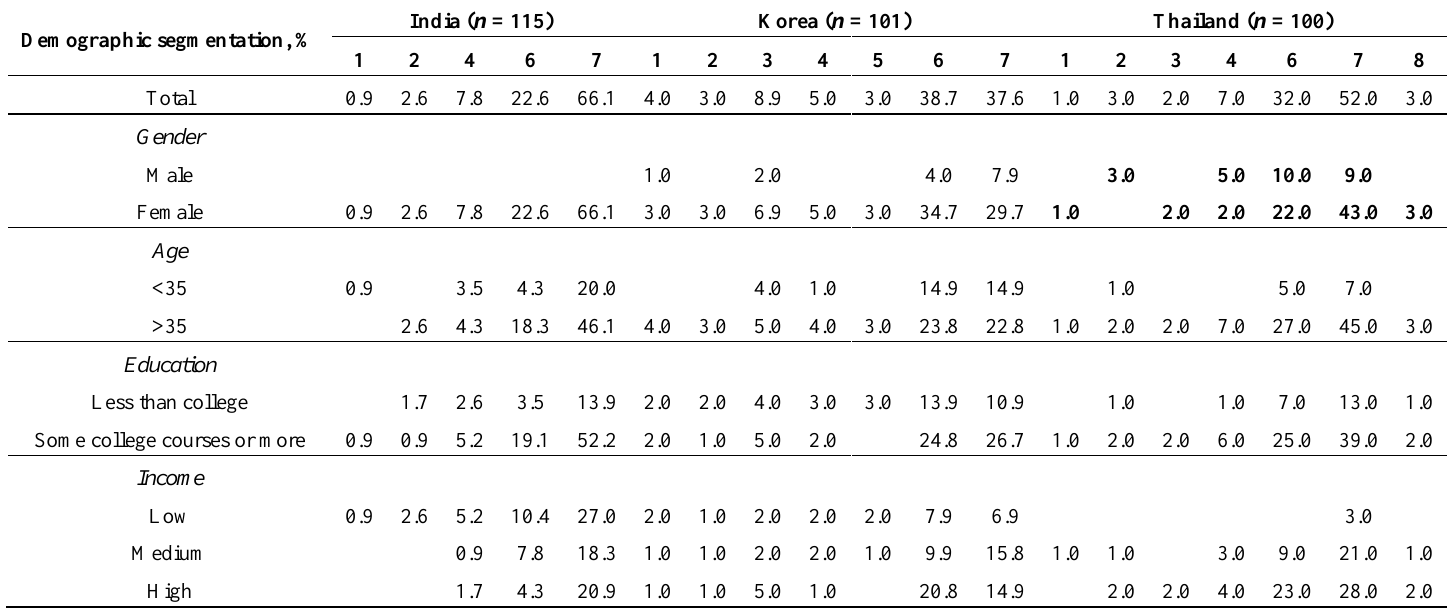
Table 9. Consumer practice of handling raw meat, poultry, seafood, or eggs. What was the first thing you did immediately after you handled these raw foods? Available options included: I cut up some other foods (1); I got other foods ready for cooking, but did not cut them up (2); I picked up a pot or pan to cook food (3); I wiped my hands off with a paper towel, dish cloth, or on my apron or clothing (4); Continued cooking without wiping, rinsing, or washing hands (5); Rinsed off my hands, but did not use soap (6); Washed hands with soap and water (7); Do not prepare raw meat, poultry, seafood, or eggs